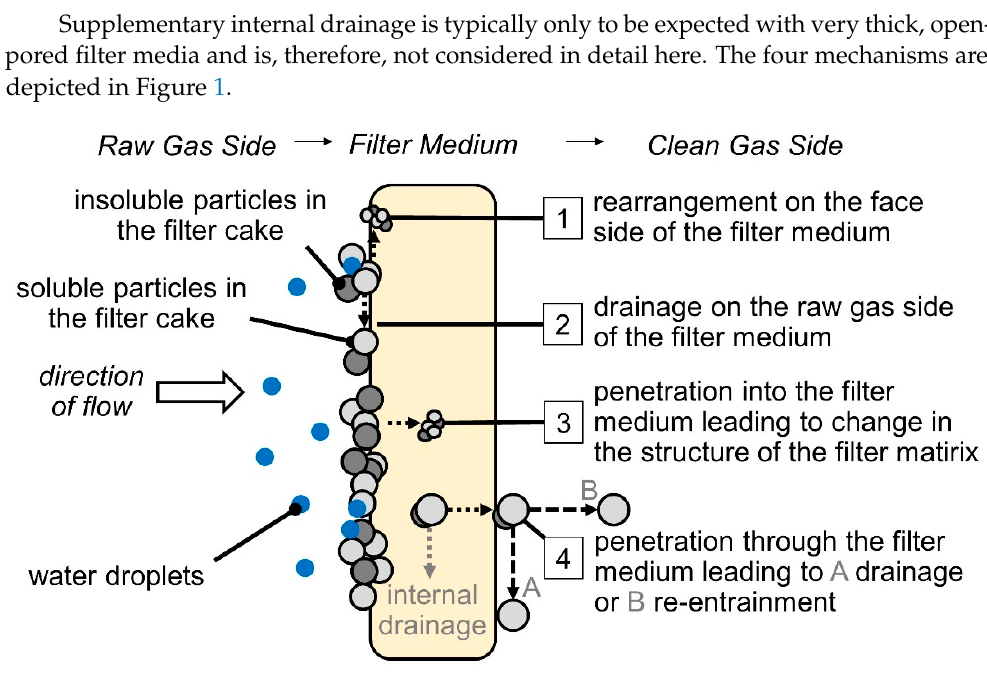
Figure 1. Four scenarios could potentially be initiated by the exposure of a surface filter with soluble and insoluble filter cake components to water mist.